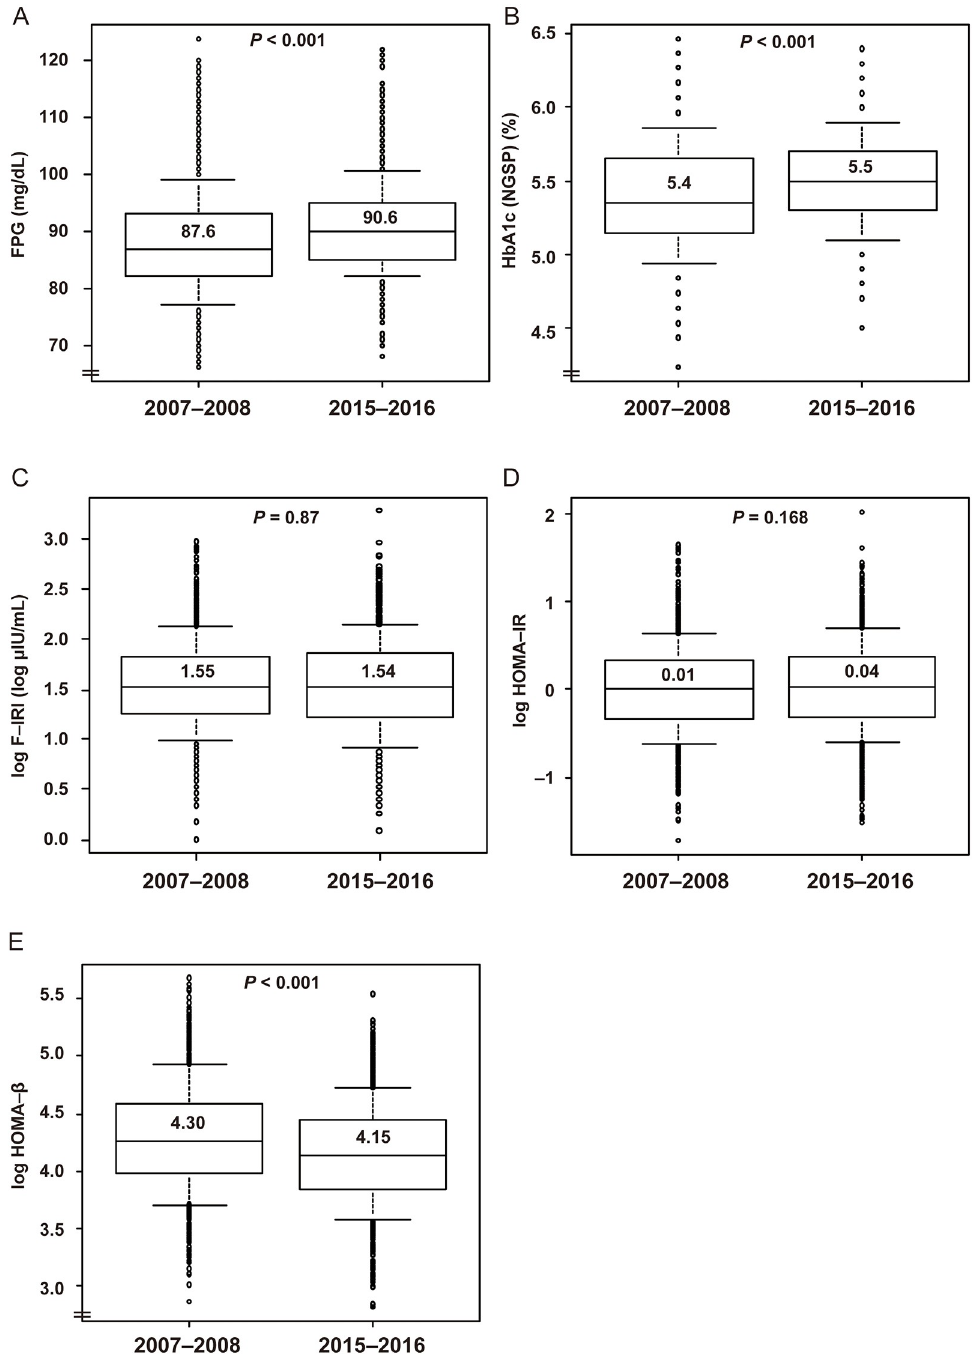
Fig 4. Box-and-whisker plots for FPG, HbA1c, F-IRI, HOMA-IR, and HOMA- β in women. Whiskers indicate the 10th and 90th percentiles. The Y axes do not start at zero in panels A, B, D, or E. F-IRI, HOMA-IR, and HOMA- β (Y-axes) are plotted on a natural logarithmic scale. Abbreviations: FPG, fasting plasma glucose; HbA1c, glycated hemoglobin; F-IRI, fasting immunoreactive insulin; HOMA- β , homeostasis model assessment of insulin secretion; and HOMA-IR, homeostasis model assessment of insulin resistance. P -values were determined using Welch’s t -test. N = 1,024 for each group.